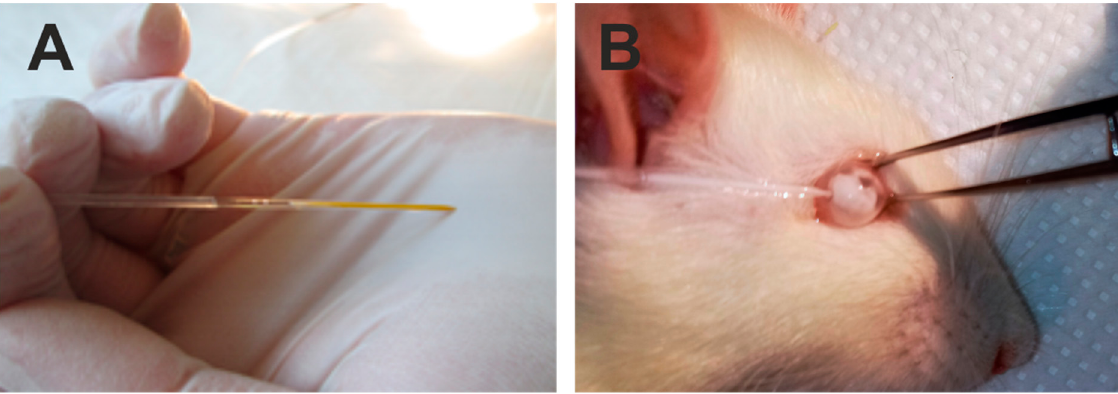
Figure 5. Illustration of the steps of the surgery of intraocular introduction of polystyrene microbeads. Injection was performed with a glass capillary filled with a suspension of viscoelastic and polystyrene microbeads ( A ) into the anterior chamber of the rat eye ( B ).